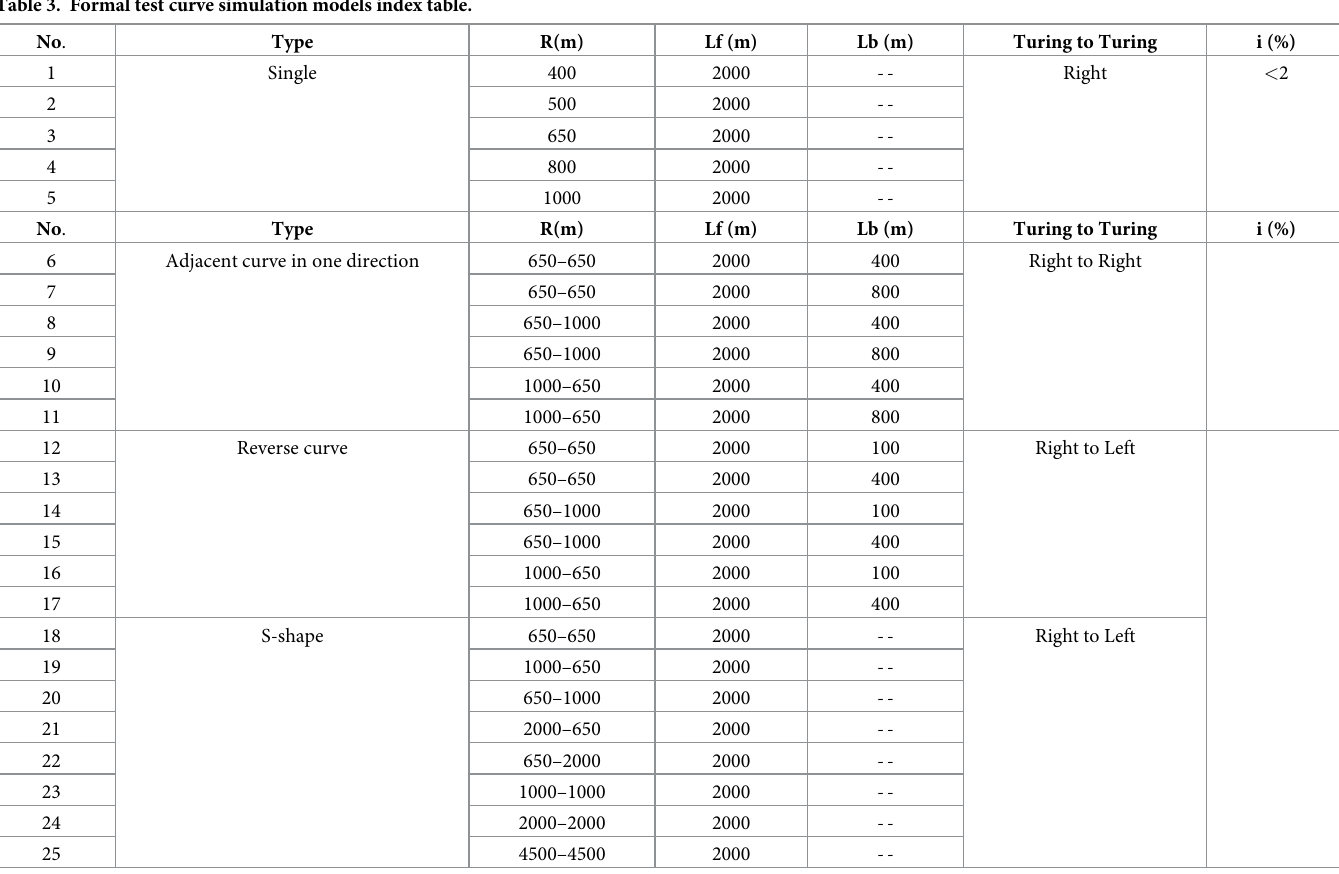
Table 3. Formal test curve simulation models index